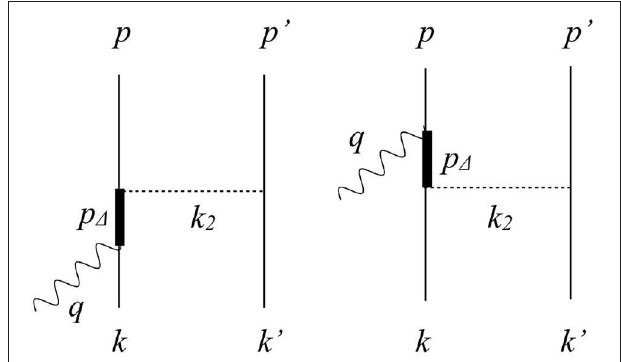
FIGURE 1 | Feynman diagrams of the 1 contribution to two-body currents. Solid, thick, and dashed lines represent nucleons, deltas, pions, respectively while the wavy line correspond to the vector